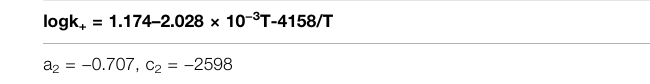
TABLE 1 | Temperature functions of the rate constants for silica-water reactions (Rimstidt and Barnes, 1980). logk + = 1.174 – 2.028 × 10 − 3